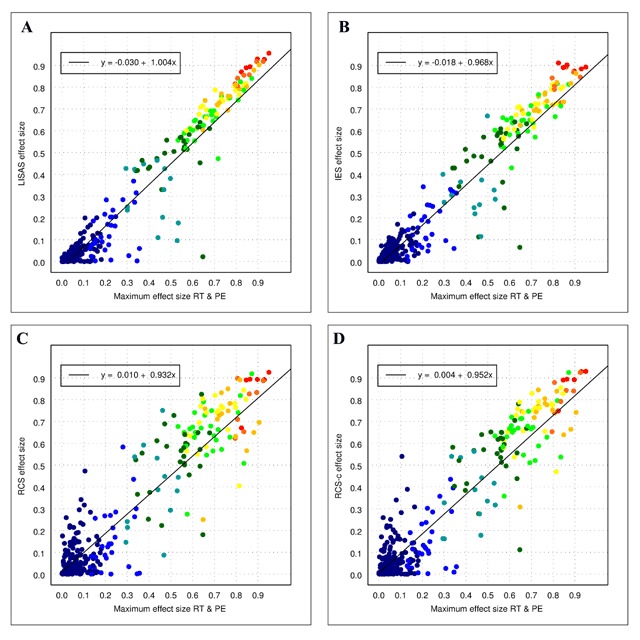
Effect sizes of all the effects in both Data Sets in LISAS (panel A), IES (panel B), RCS (panel C), and RCS-c (panel D) as a function of the maximal effect size in RT and PE. The colours of the plotted points indicate the average effect size obtained by RT and PE: dark blue (up to 0.1), blue (<0.2), cyan (<0.3), dark green (<0.4), green (<0.5), yellow (<0.6), orange (<0.7), red orange (<0.8) and red (<1.0).